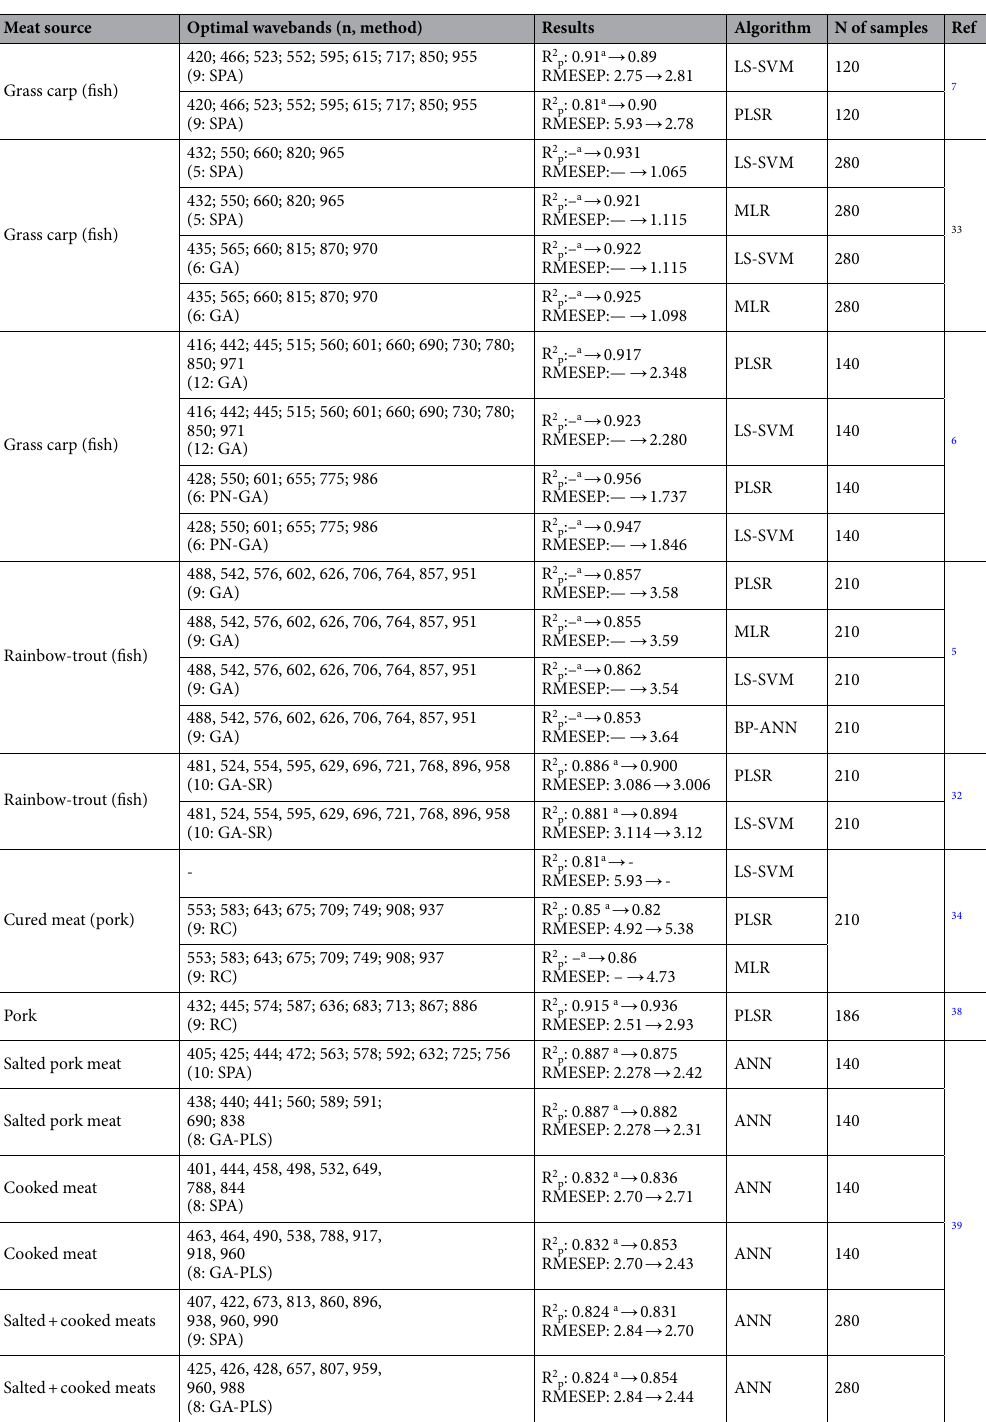
Table 3. Prediction results of the TVB-N values of several meat products by hyperspectral imaging system. SR stepwise regression, PN Physarum network (PN), GA genetic algorithm (GA), RC regression coefficient, SPA successive projection algorithm, R 2 P adjusted determination coefficient of prediction, RMSEP root-mean- square errors estimated by prediction, MLR multi-linear regression, PLSR partial least squares regression, LS-SVM least squares support vector machine, BP-ANN back-propagation artificial neural network, ANN artificial neural network. a The results of quantifying model based on full spectral